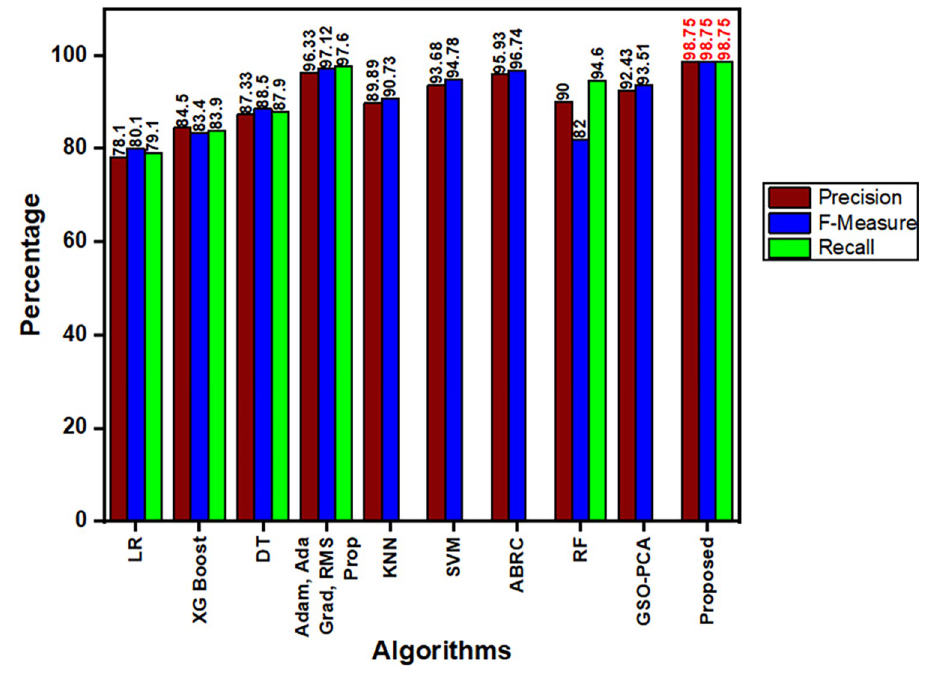
Fig 10. Performance metrics comparison of various